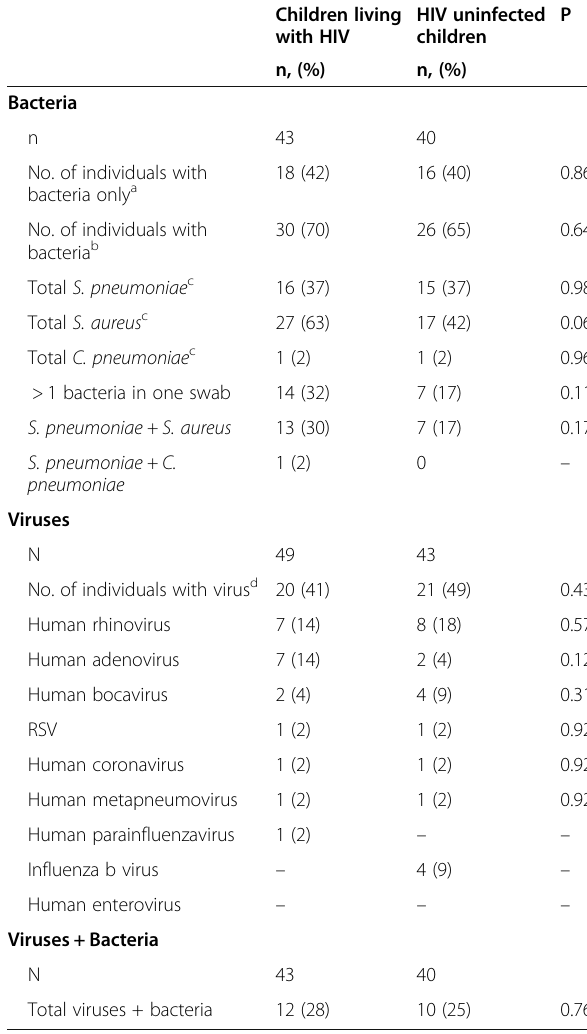
Table 4 Nasopharyngeal bacteria and viruses identified in children living with and without Children